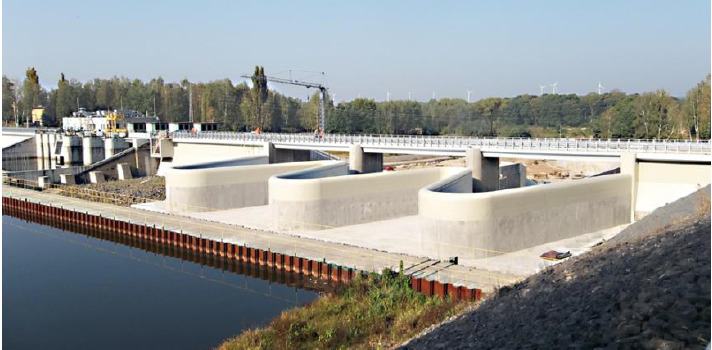
Figure 15. The reconstructed Niedów dam (September 2016). A view of the labyrinth weir and the steel cofferdam, which will not be dismantled.